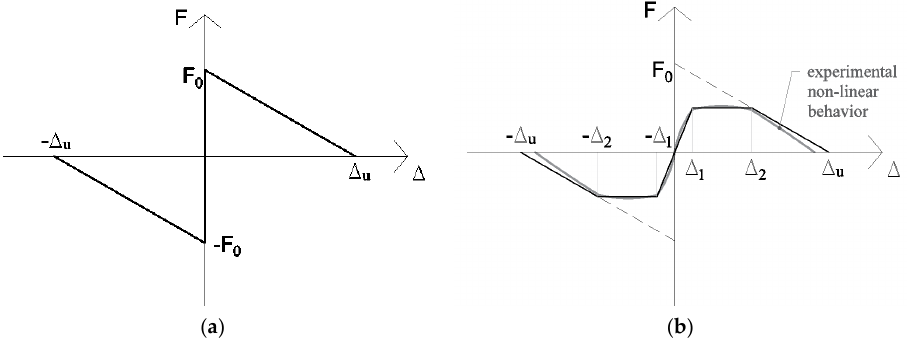
Figure 5. Force-displacement law for the rocking block: ideal model ( a ); model with imperfections ( b ).